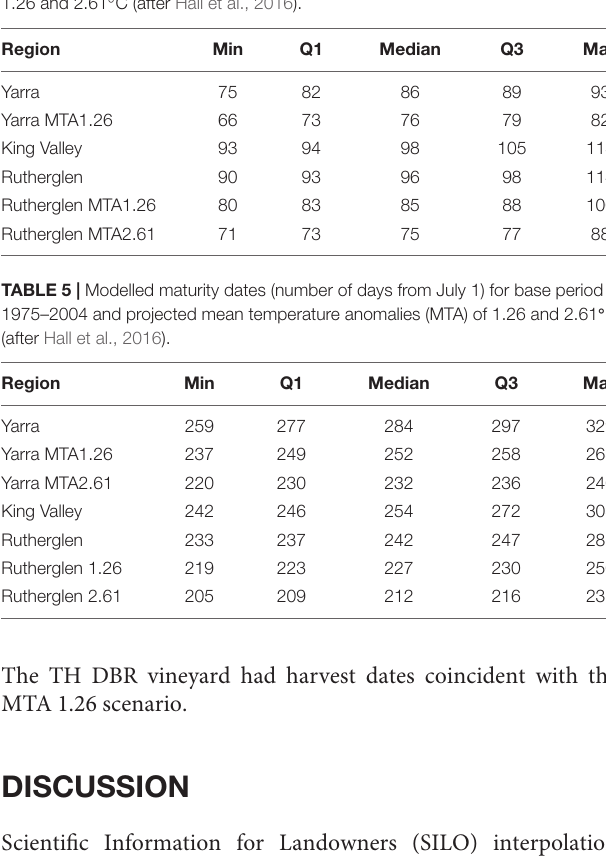
TABLE 4 | Modelled budbreak dates (number of days from July 1) using a 1975–2004 base period and projected mean temperature anomalies (MTA) of 1.26 and 2.61 ◦ C (after Hall et al., 2016).